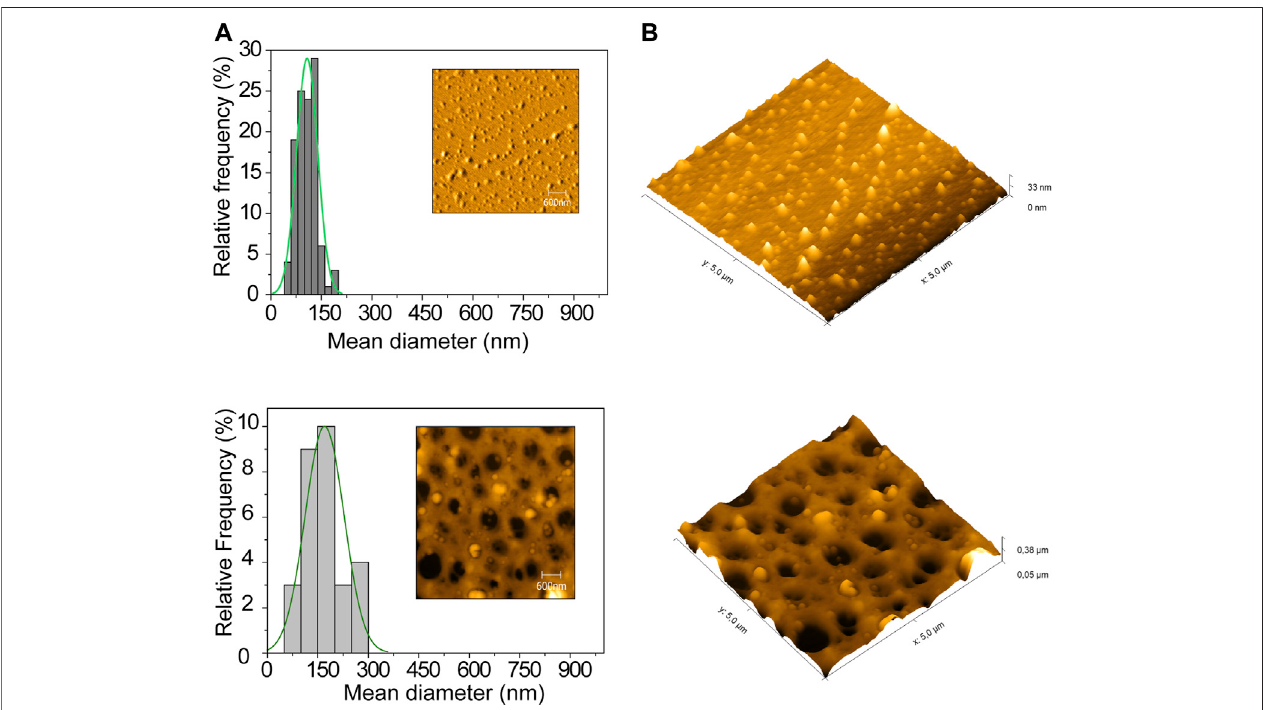
FIGURE 2 | Atomic force microscopy results (area of 5 μ m × 5 μ m): (A) Size distribution pro fi le and surface topography image of the NLCs loaded with the active agents, in suspension and entrapped in gel; (B) 3D topography of the NLCs in suspension and entrapped in gel.